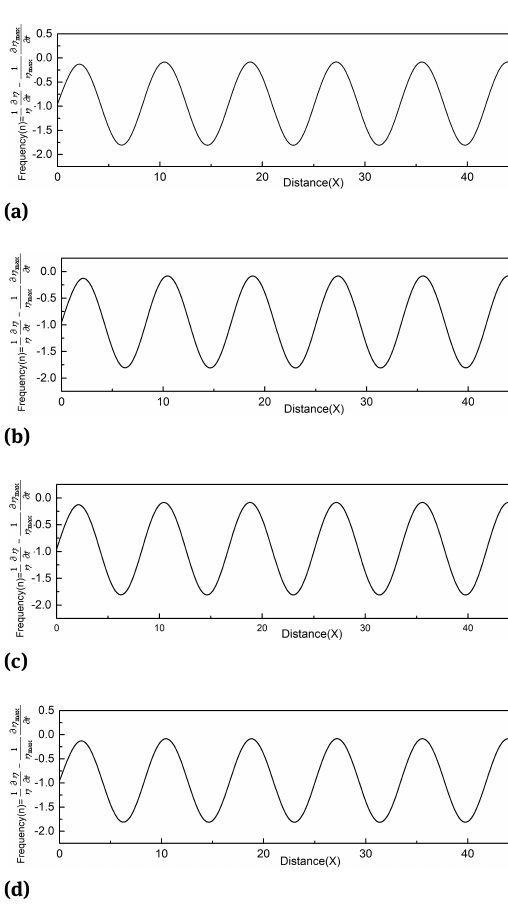
Fig. 4: Different values of B=0.01, 0.02, 0.03 and 0.04 with fixed values of β = 2, M = 0.3, (cid:96) = 0.75 and β −6 . 0 1 = 3.3 × 10 −6 . 1 = 3.3 × 10 that point and elevation η . Figures 2–4 predicts the spa- tial structure of growth rate of interface in terms of n NL − ∂η ∂η max n NL , Max = 1 − 1 at an early stage (initial η η max ∂t ∂t